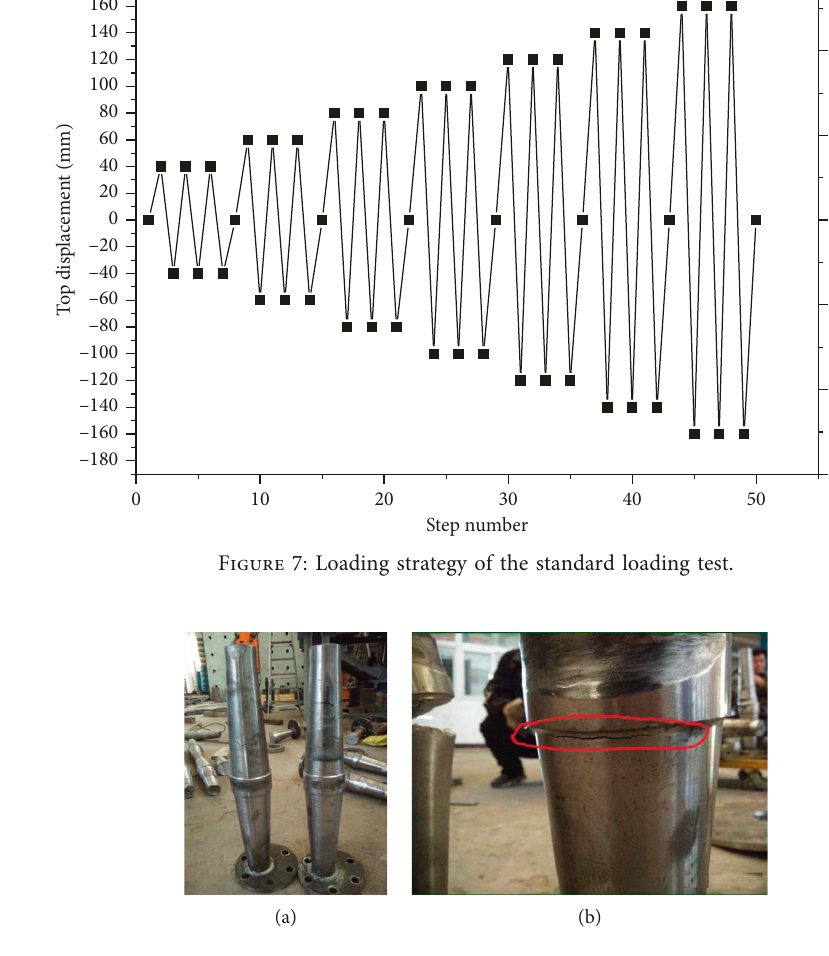
Figure 8: Failure form of specimen